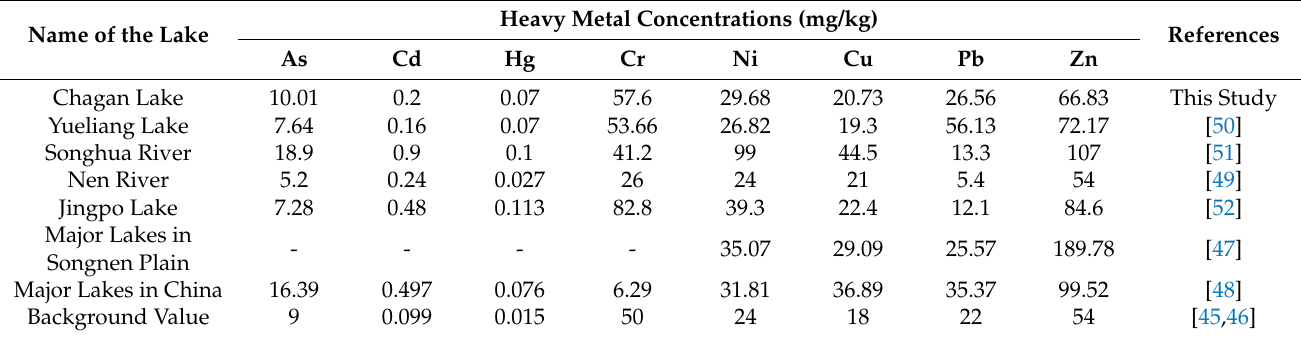
Table 2. Heavy metal concentrations in the surface sediments from Chagan Lake and other selected lakes.